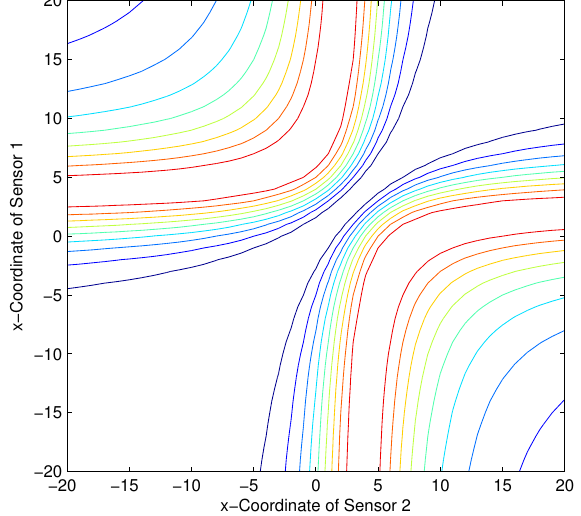
Figure 10. Variation of Fisher information determinant value with the range sensors positions (Contour